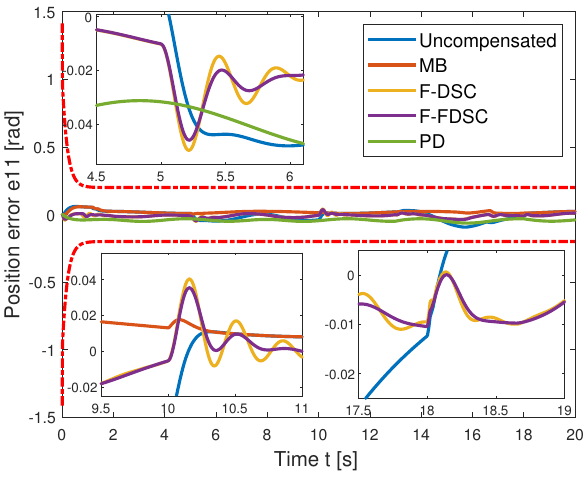
Figure 14. Position error e 11 .